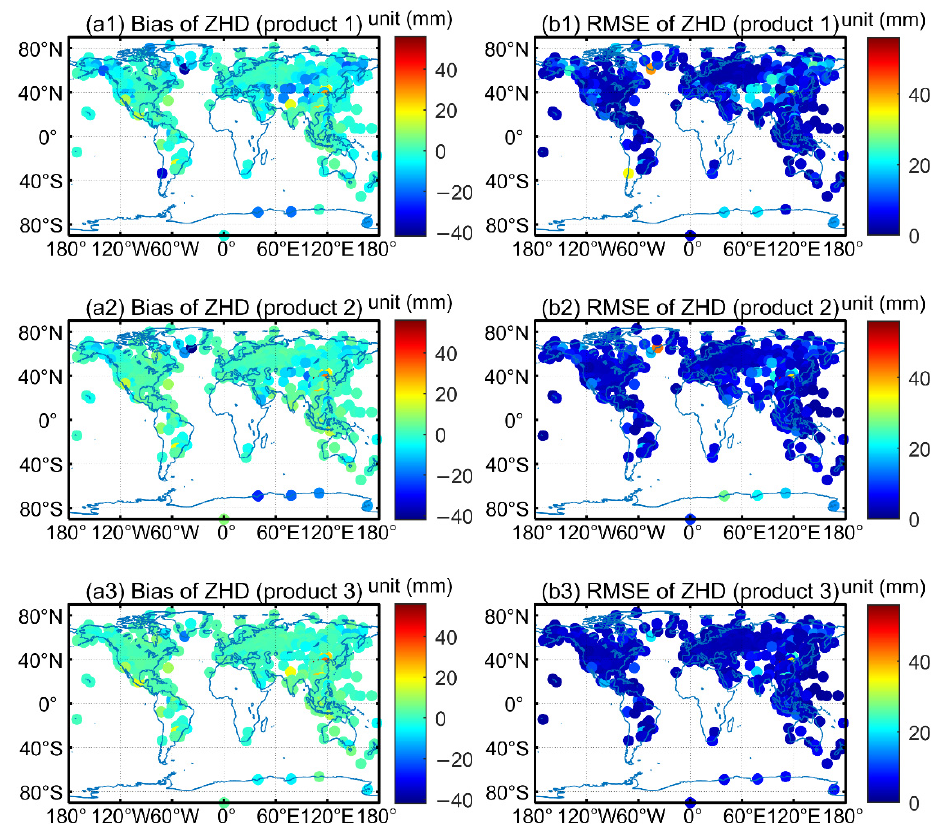
Figure 3. Bias ( left ) and RMSE ( right ) of ZHD at each of the 443 radiosonde stations from 1 July 2018 to 30 June 2021 resulting from product 1 ( top ), product 2 ( middle ), and product 3 ( bottom ). Table 3. Statistical results of all the 443 stations shown in Figure 2 for the three products. Product